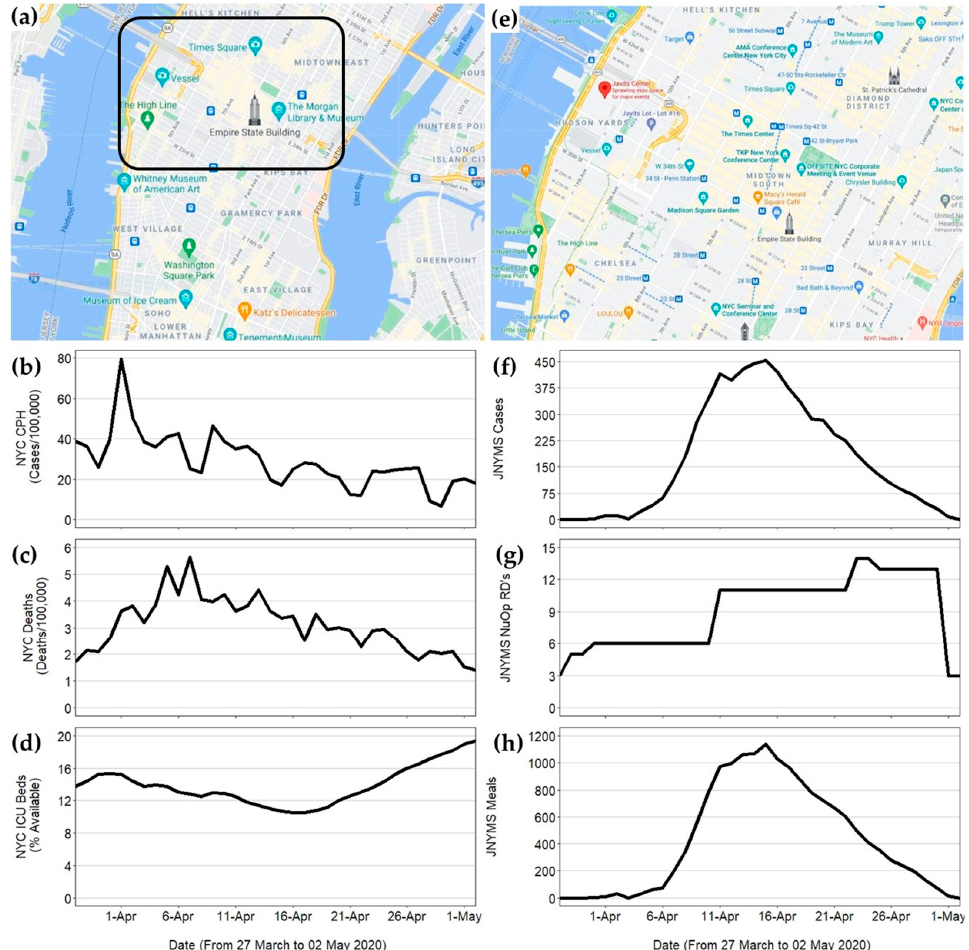
Figure 1. Maps of New York City (NYC) and the Javits New York Medical Station (JNYMS) location (panels ( a ) and ( e ), respectively) and multi-panel time series plots for NYC’s. ( b ) COVID-19 cases per 100,000 persons, ( c ) deaths per 100,000 persons, and ( d ) and hospital bed availability, as well as JNYMS’ ( f ) patient census, ( g ) number of NuOp RDs, and ( h ) total meals served per day